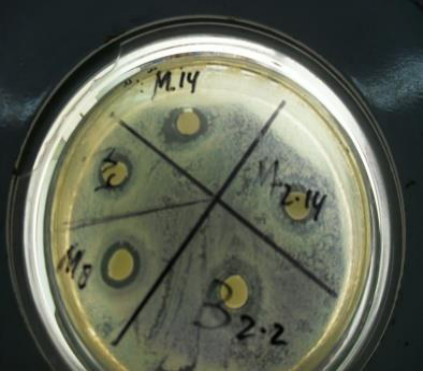
Figure 5. Results of the antimicrobial analysis of Lactobacillus plantarum lactid acid bacteria onto E. coli and S. aureus testing bacteria. Table 2. Antimicrobial activity analysis of LAB in the form of clear zone diameter